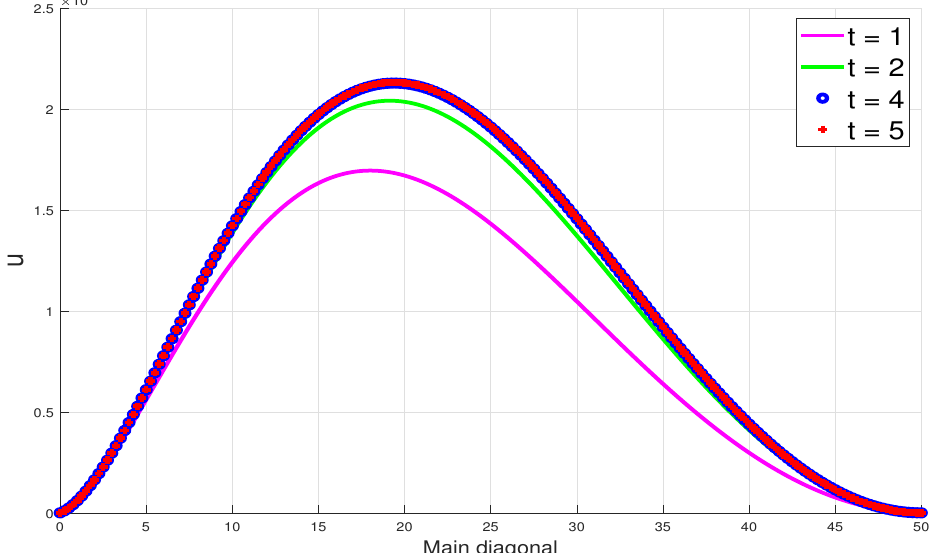
Figure 5. Time development of steady-state axial velocity